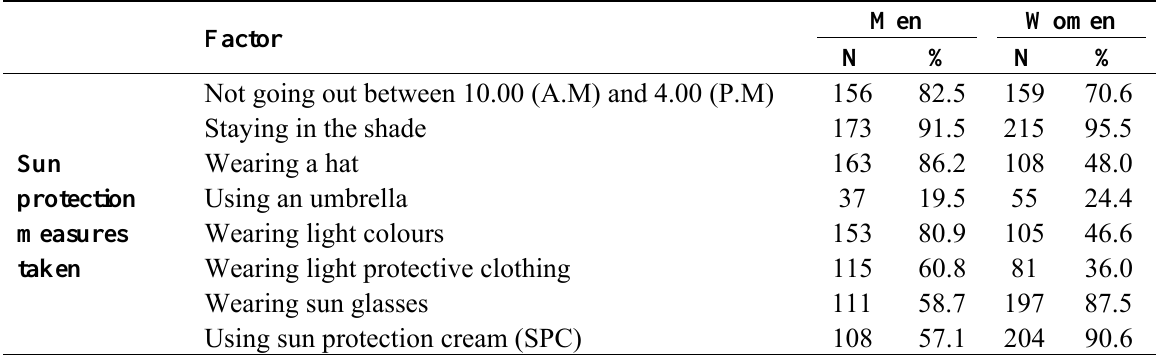
Table 2. Students’ applied protection methods from sun light.